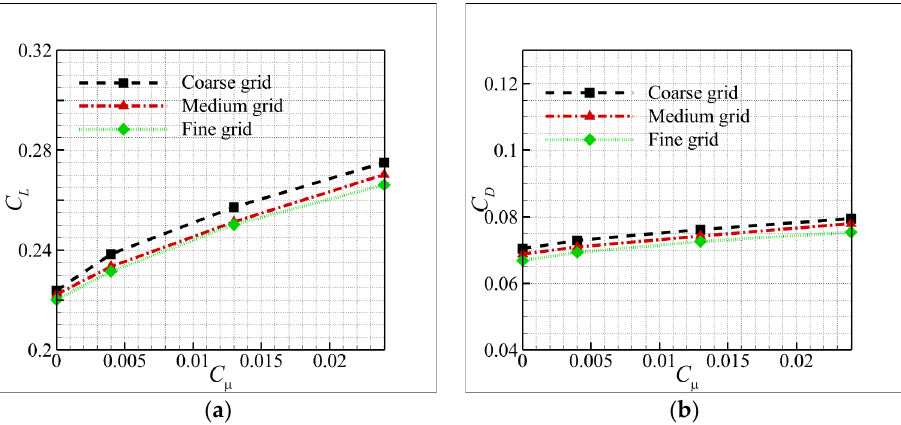
. ( a ) Lift coefficient; ( b ) Drag coeffi-